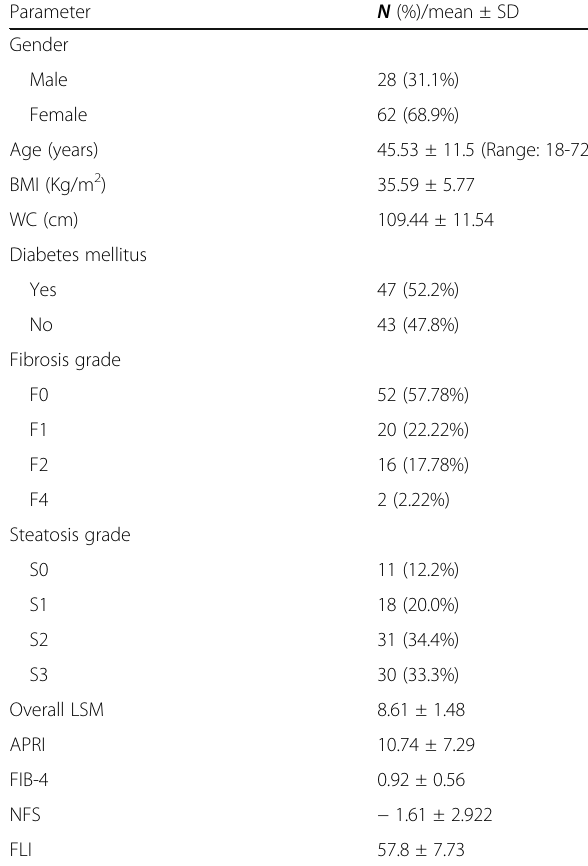
Table 1 Basic patients ’ demographic data and characteristics